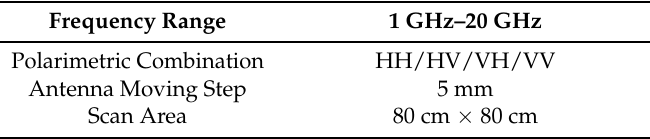
Table 1. Measurement parameters of the GB-SAR